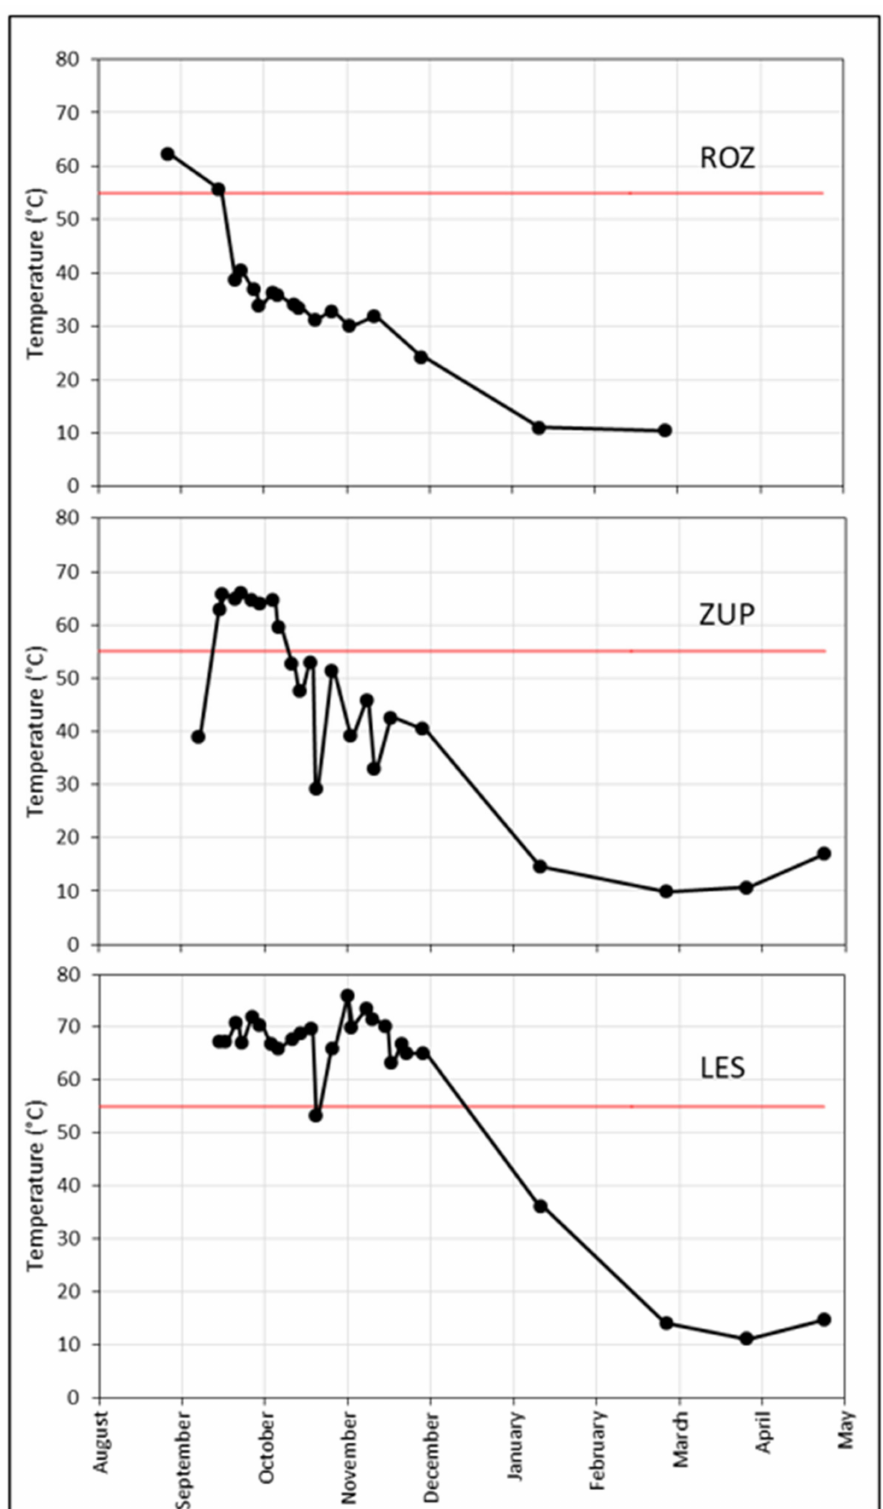
Figure 3. Dynamic of temperature in observed compost piles during composting from September to end of April. The red line represents hygienization at 55 ◦